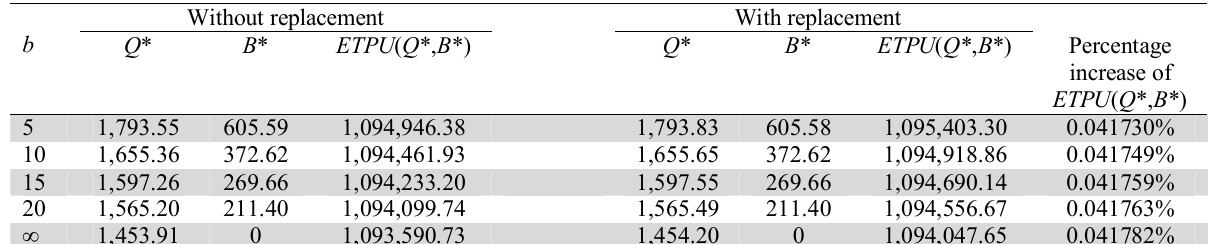
Optimal solutions for different backordering cost, D = 50,000, x =175,200, K =100, h = 5, d = 0.5, c